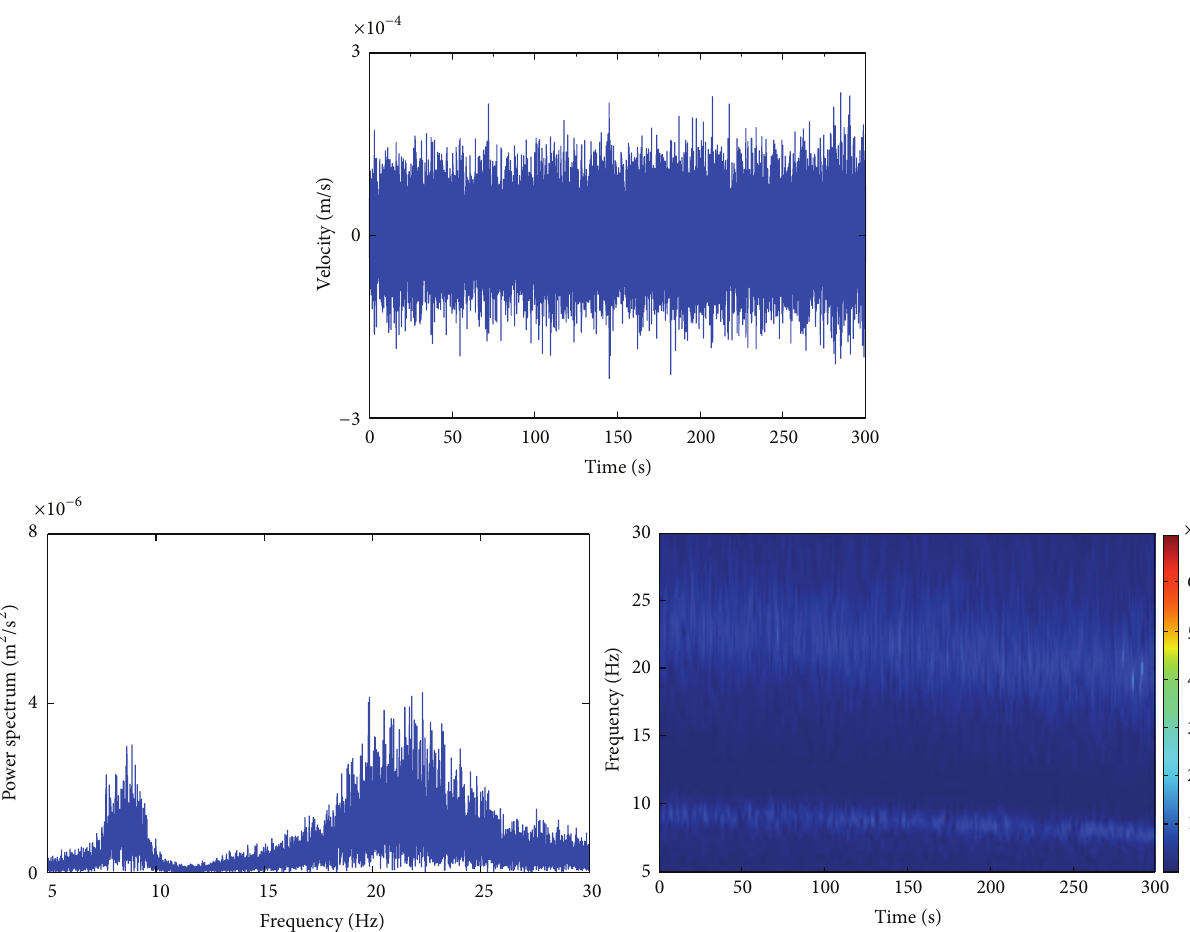
Figure 5: Complex Morlet transform scalogram of the velocity response.